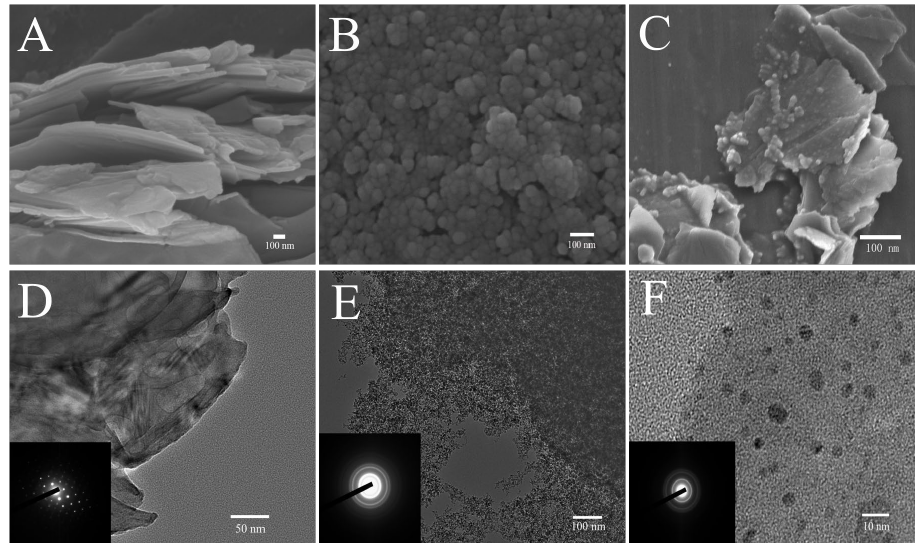
Figure 1. SEM images of BPNPs ( A ), ND ( B ), ND@BP ( C ). TEM images of BP ( D ), ND ( E ), and ND@BP ( F ) with electron diffraction patterns (inset).